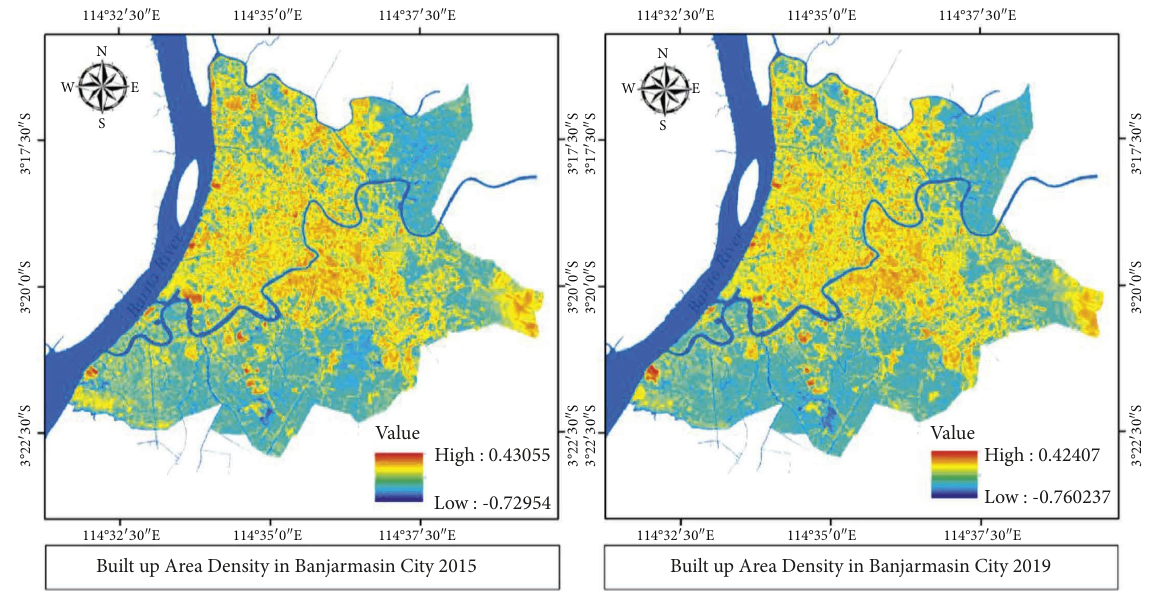
Figure 1: Built-up area density of Banjarmasin City in 2015 and 2019.